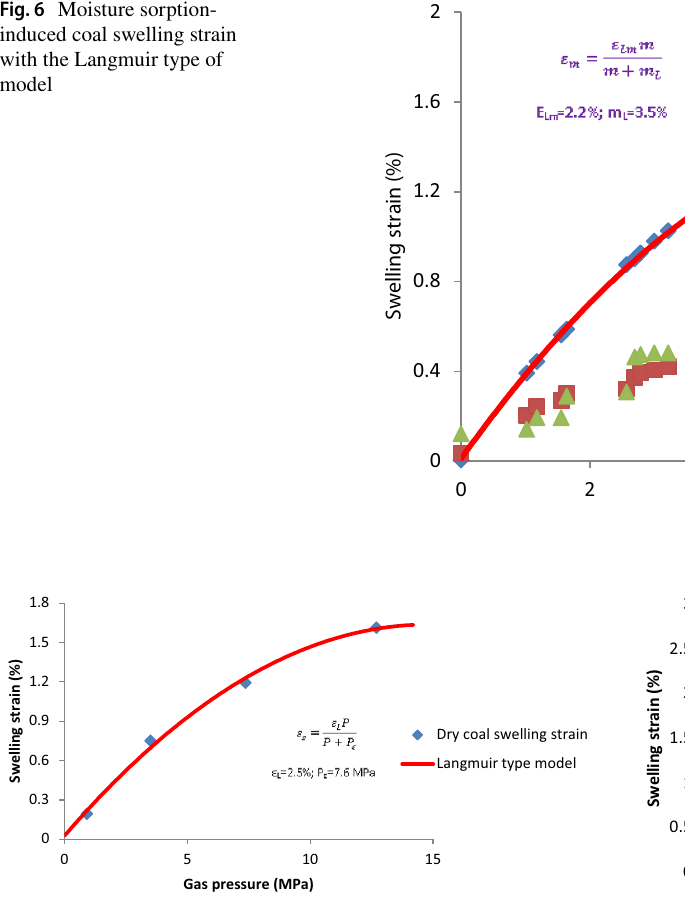
Fig. 7 Methane sorption-induced swelling strain of dry coal with the Langmuir type model Fig. 8